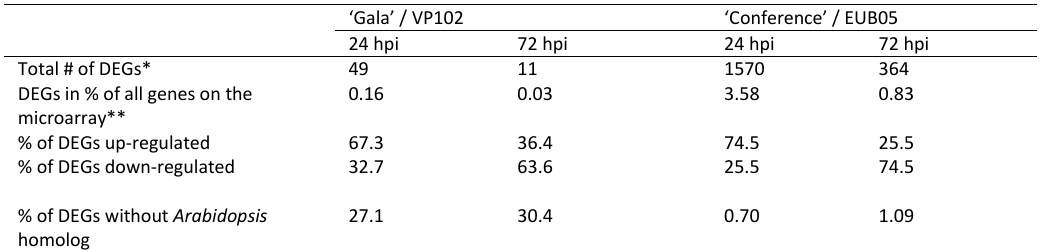
Table 2 : Number of DEGs identified during apple and pear nonhost response to V. pyrina and